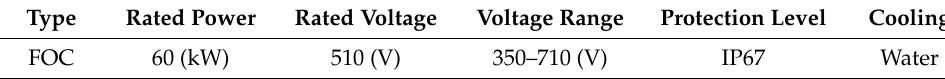
Table 2. Parameters of the EM inverter.